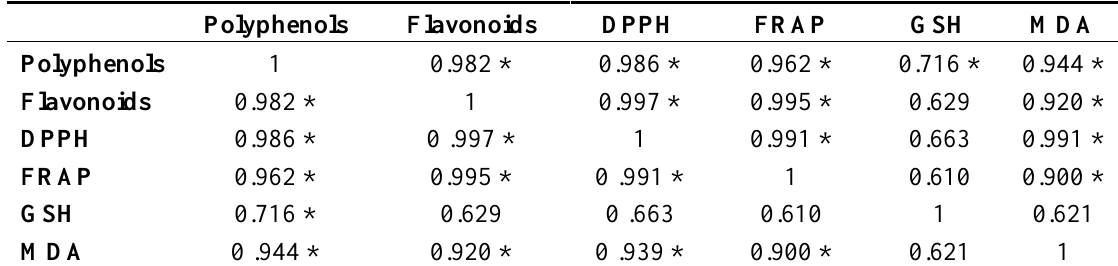
Table 2. Correlation matrix showing the interrelation among the levels of polyphenols, flavonoids, DPPH, FRAP, GSH and